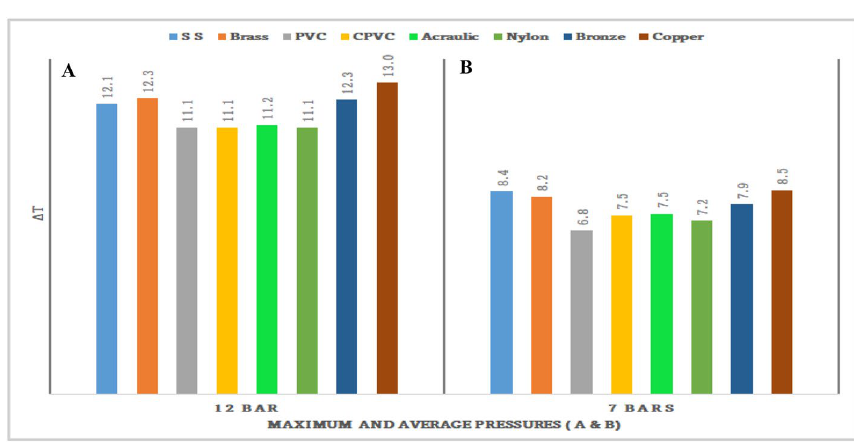
Figure 74. Maximum and average pressures versus maximum temperature (∆T) difference.